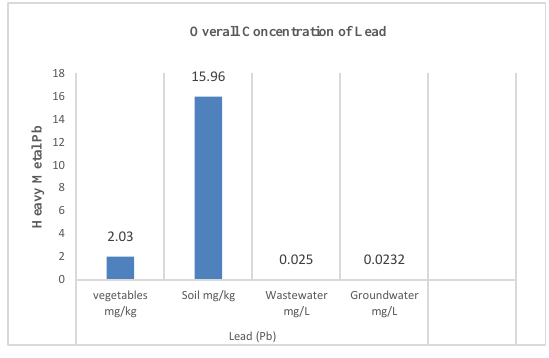
Figure 5: Overall Concentration of Lead